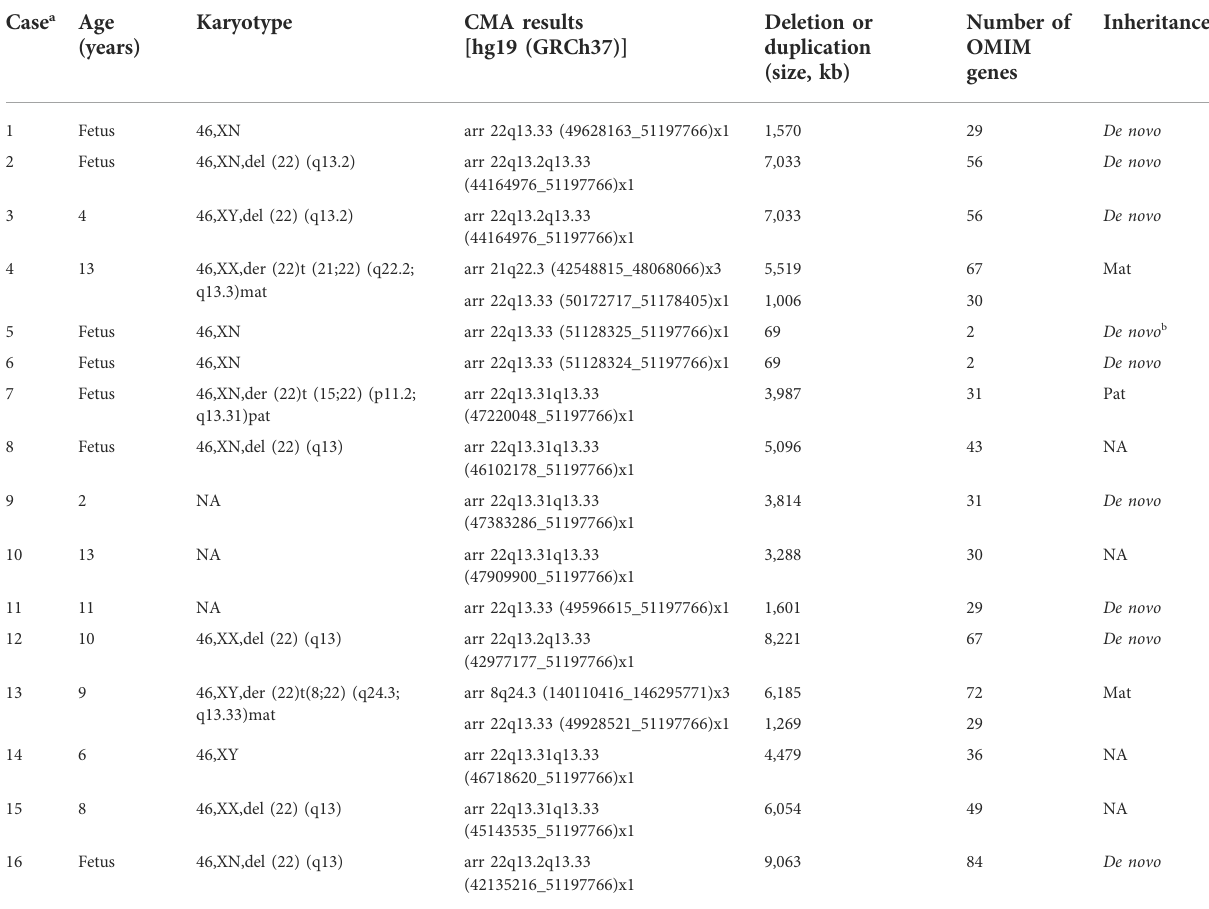
TABLE 1 Details of the 22q13.3 deletions identi fi ed in 16 individuals with